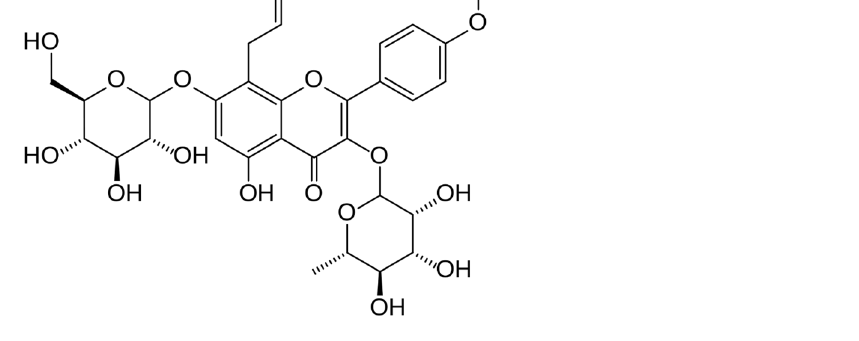
Figure 6. The chemical structure of icariin, which is commonly found in the extracts of Epimedii Herba. [63].